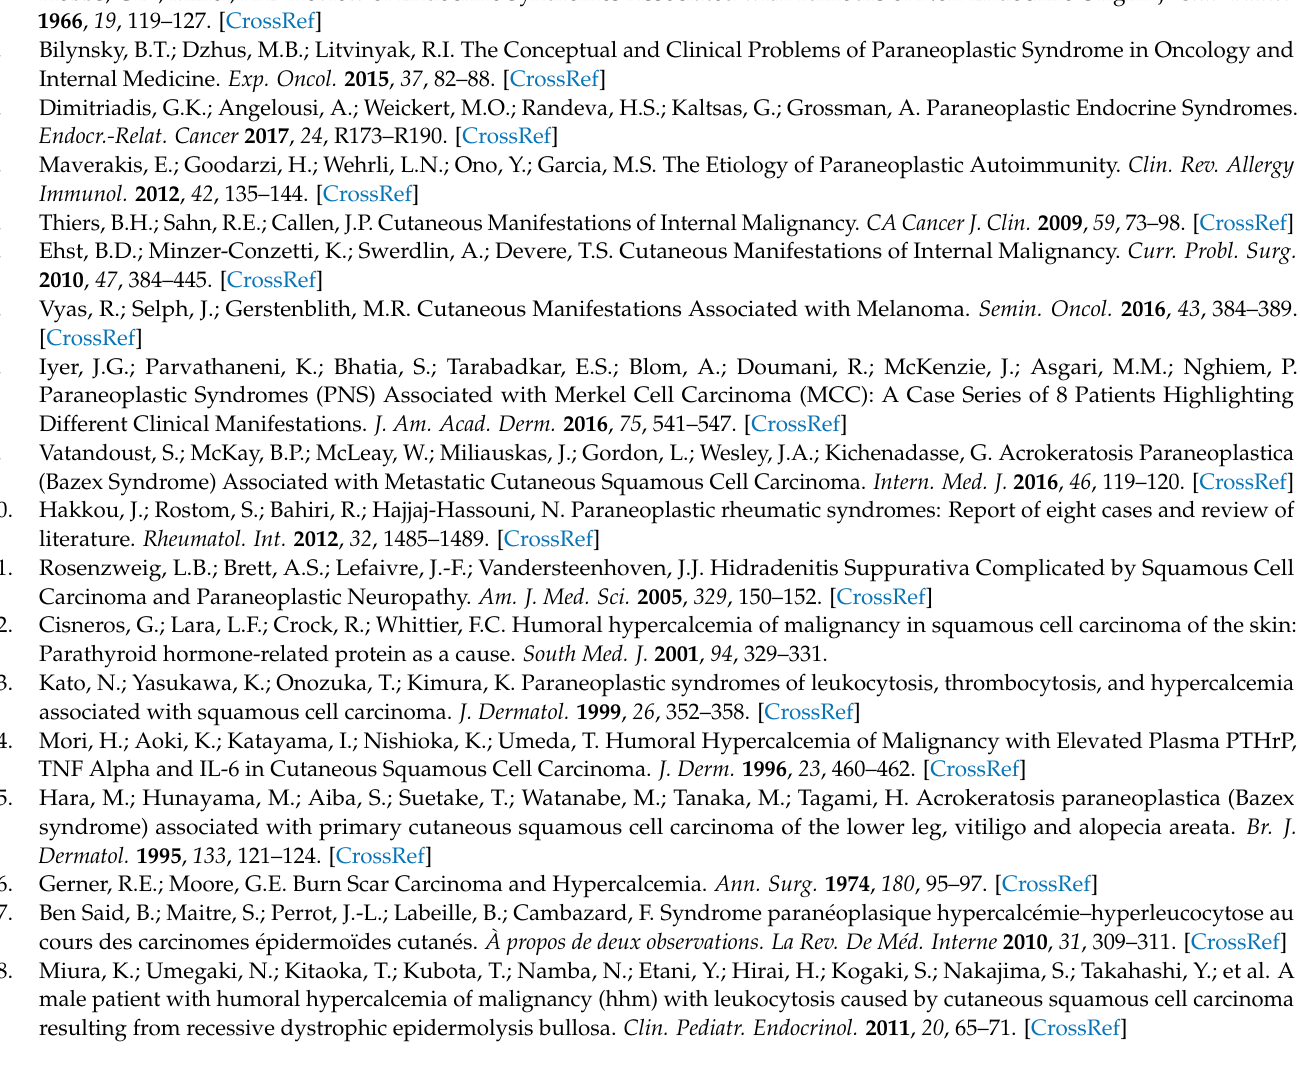
Paraneoplastic syndromes in patients with keratinocyte skin cancer. Compilation of the clinical features stratified according to the different skin cancer types. No (%): Number of cases and distribution of the cases among the different cancer types (% of cases with available information), Table S3: Malignancy associated hypercalcemia (MAH) in KSC patients: Per patient laboratory findings of the N = 32 cases with